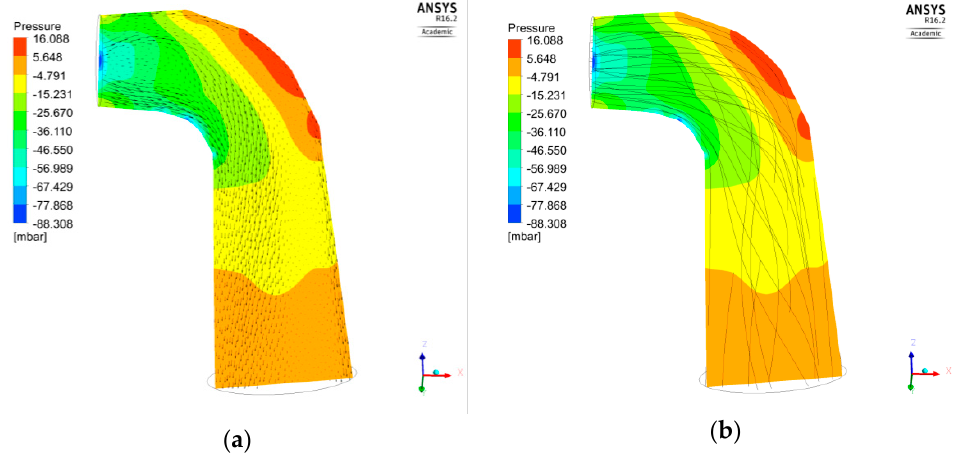
Figure 2. Pressure distribution, velocity vectors ( a ), and streamlines ( b ) in the analyzed domain for flow rate of 0.9 Q 0 and outlet pressure of 5621 Pa.